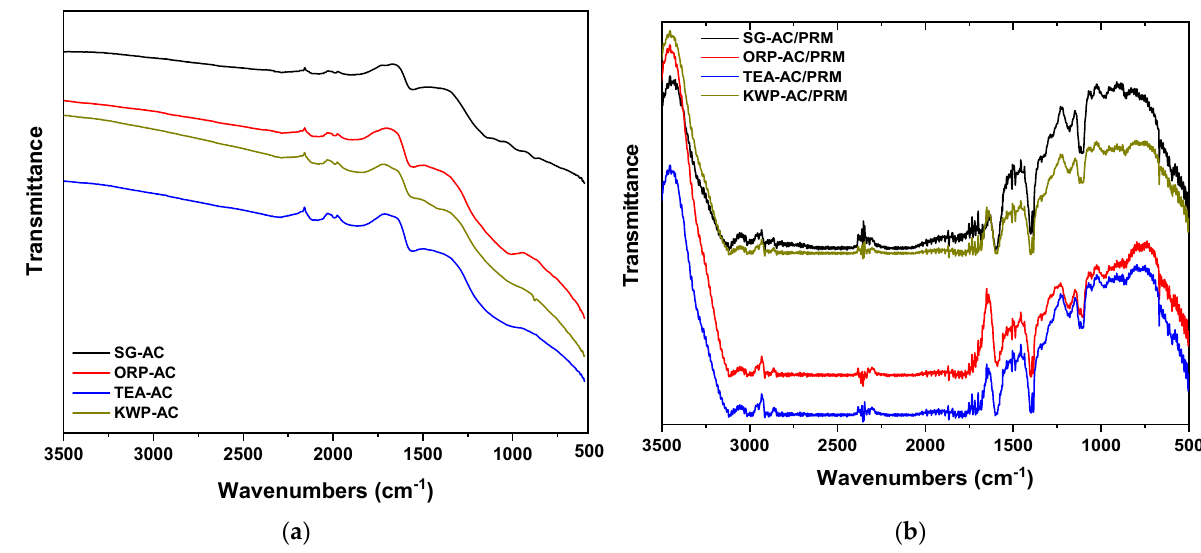
Figure 4. FTIR spectra of the prepared AC samples ( a ) before PRM adsorption and ( b ) after PRM